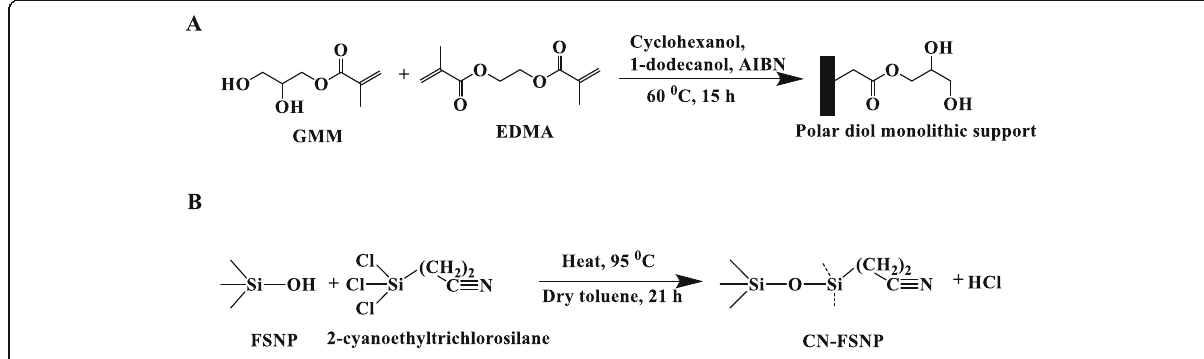
Fig. 1 Schematics of the fabrication of poly(GMM-co-EDMA) monolithic support ( a ) and preparation of CN-FSNPs ( b